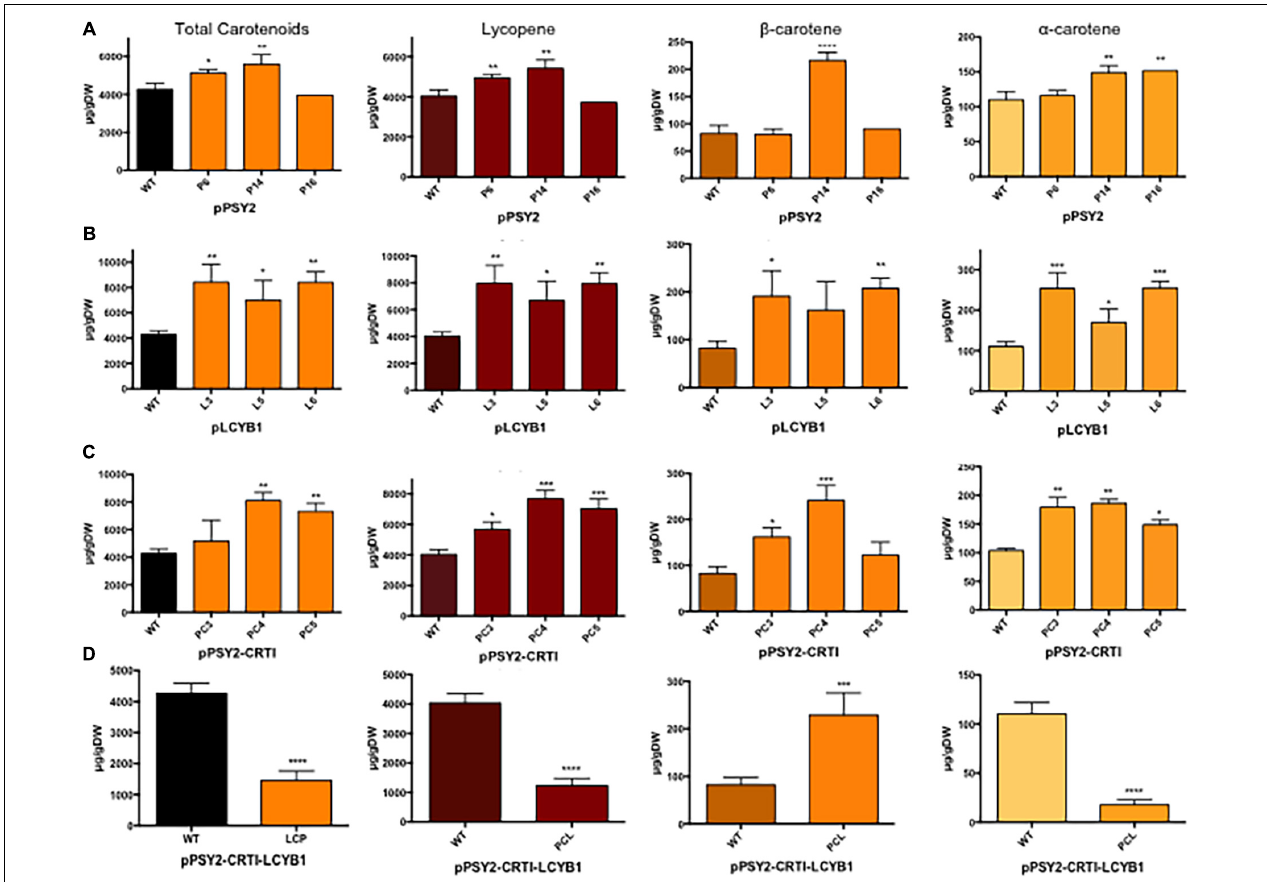
FIGURE 5 | Total and individual carotenoid quantification in pCP-CG transgenic lines. (A) pPSY2, (B) pLCYB1, (C) pPSY2-CRTI, and (D) pPSY2-CRTI-LCYB1 transgenic lines. Total carotenoids were quantified in fruits by spectrophotometry at 474 nm and individual carotenoids by HPLC expressed in µ g/gDW. Asterisks indicate significant differences respect to the control (WT) determined by one-way ANOVA and Dunnet post-test, * p < 0.05, ** p < 0.01, *** p < 0.001. In (D) the results were analyzed with a two-way t -test, **** p <